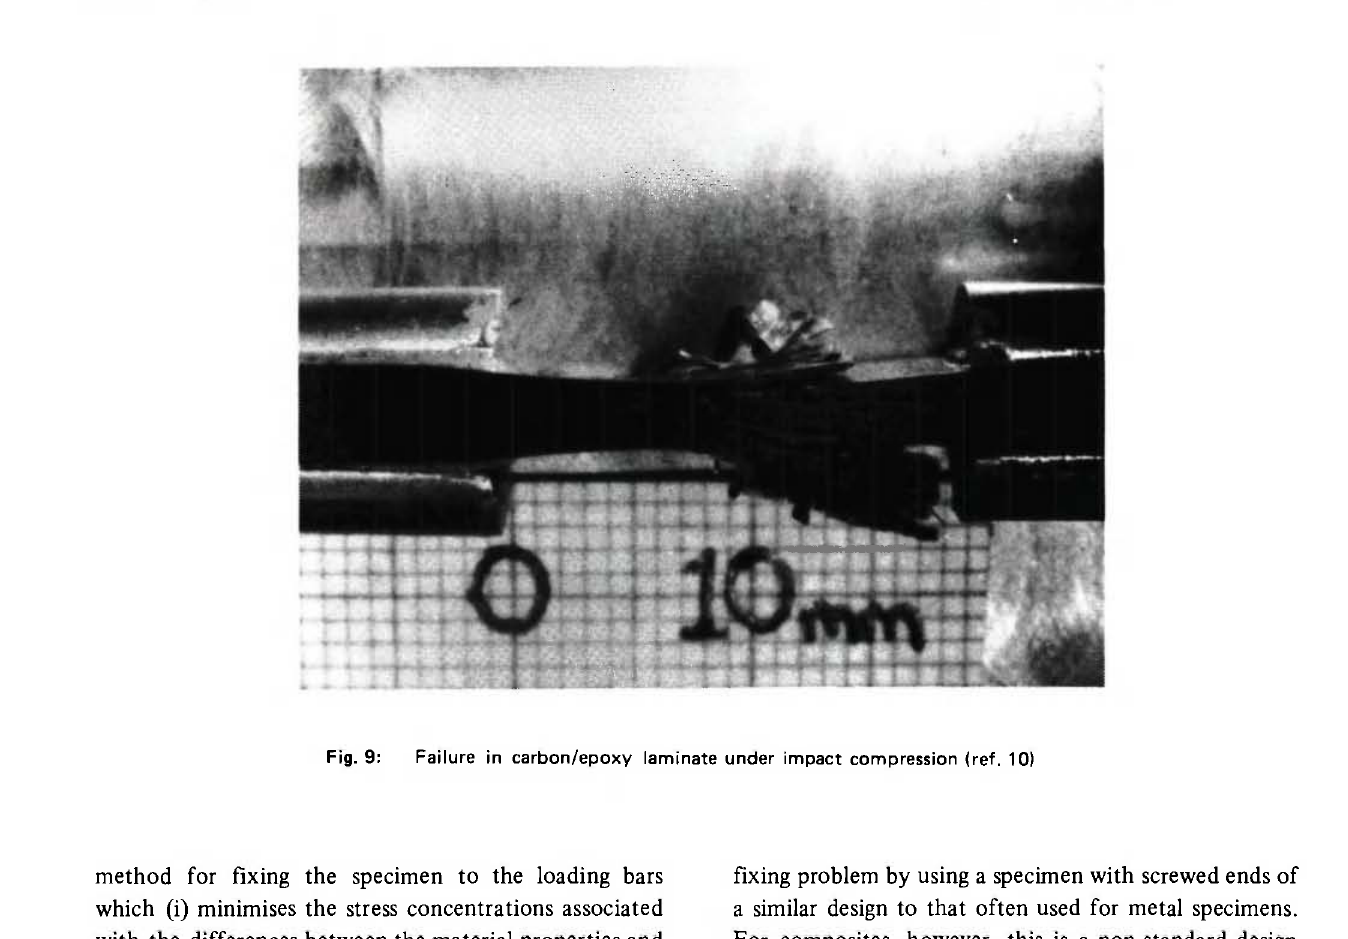
Fig. 9: Failure in carbon/epoxy laminate under impact compression (ref.